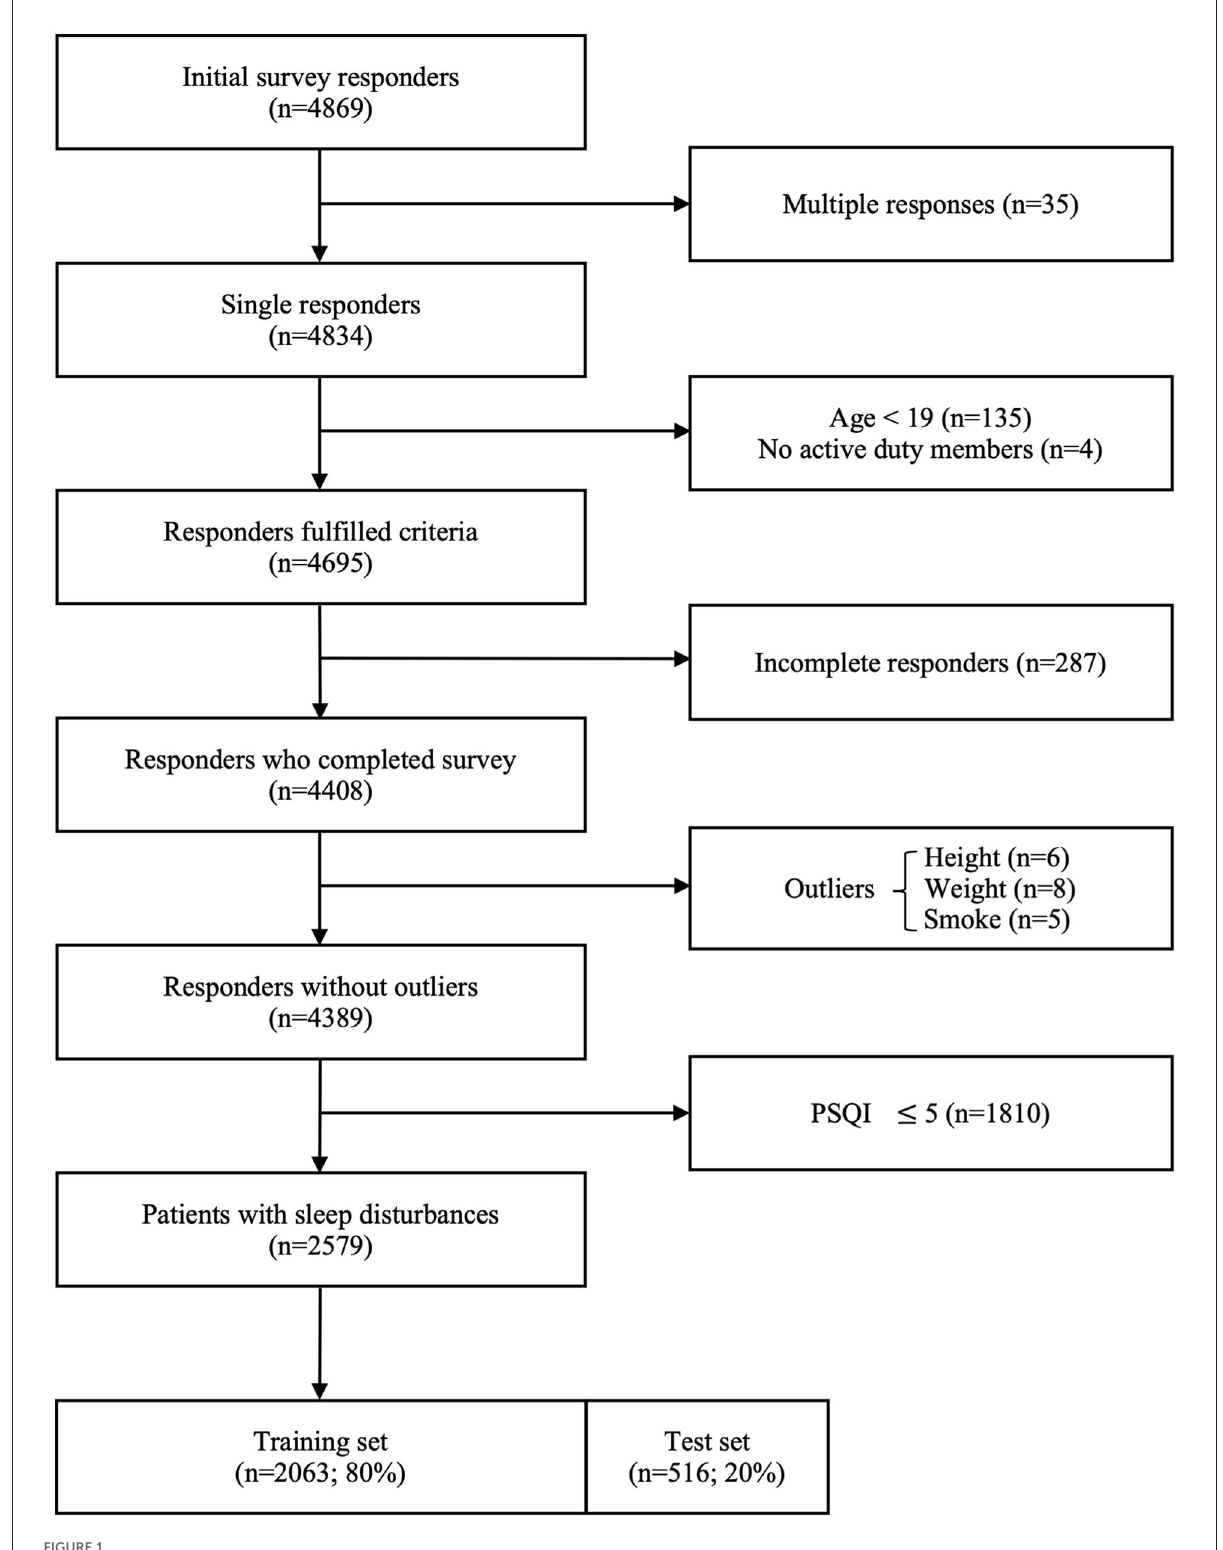
FIGURE1 Flow chart illustrating the construction of the data set for the